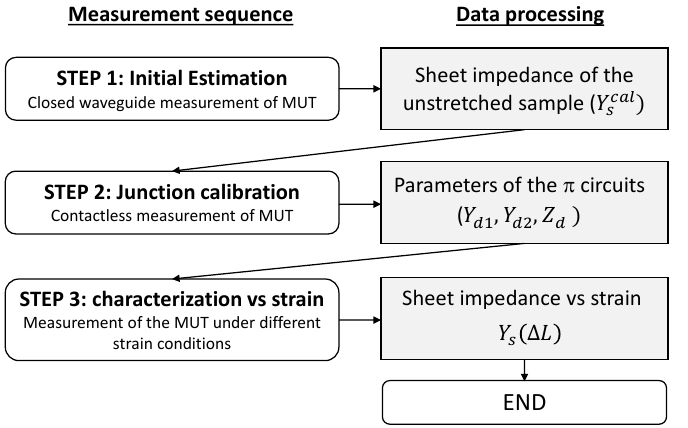
Figure 1. Block diagram of the proposed approach for the characterization of piezoresistive materials. MUT: Material Under Test.